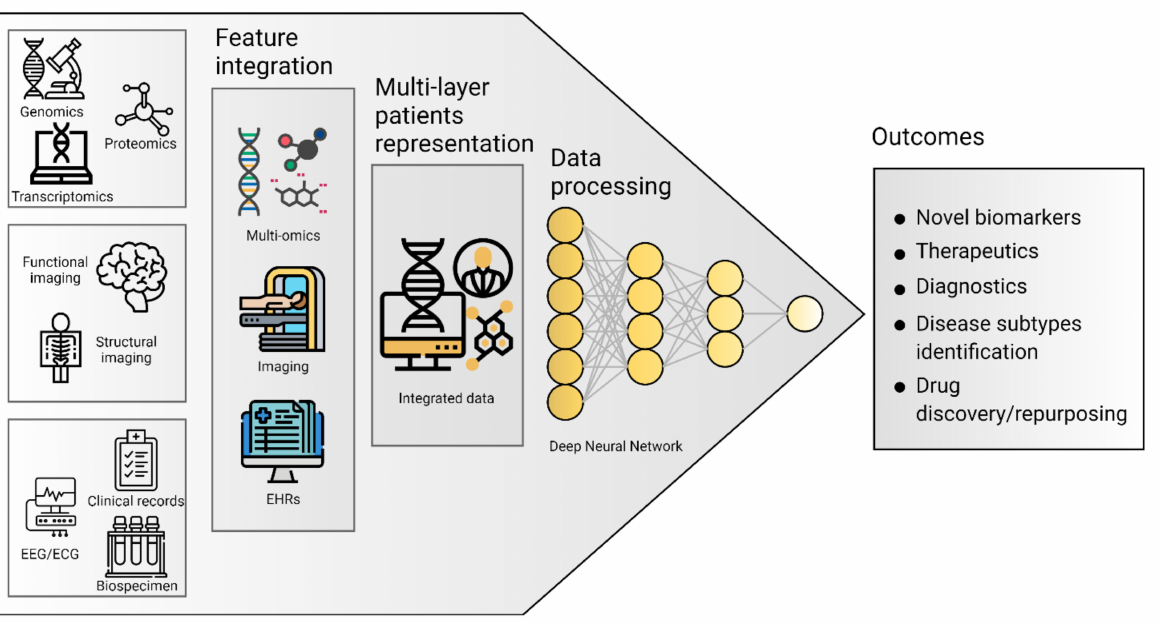
Figure 5. Multi-layer picture of neurodegenerative diseases. Separated data can be integrated to obtain a holistic representa- tion of patients. Artificial intelligence techniques application for data processing leads to useful findings in ND research, clinical management, and personalized treatment